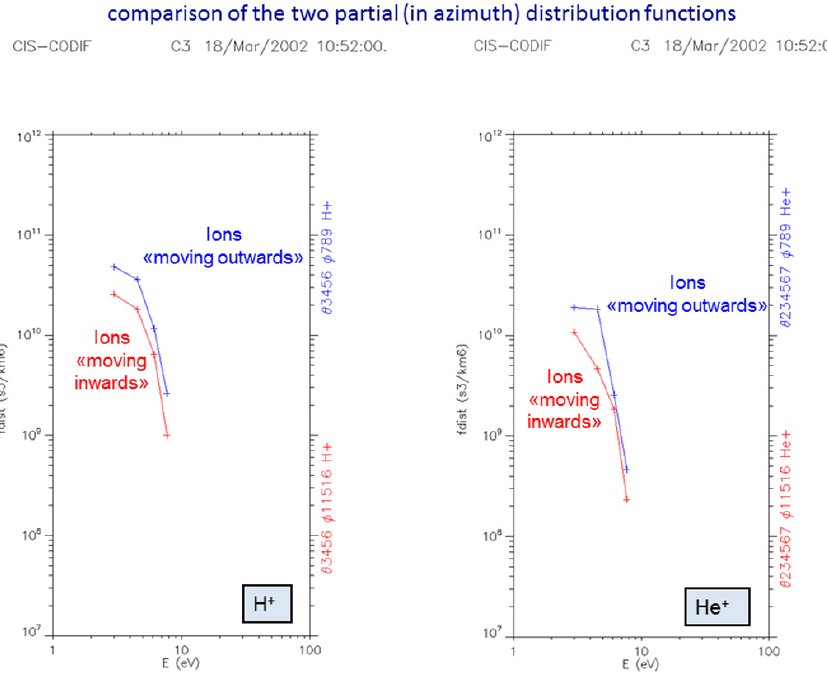
Fig. 5. Partial distribution functions in the outer plasmasphere and close to the magnetic equator, corresponding to ions flowing radially outwards (blue plots) and to ions flowing radially inwards (red plots). Left panel is for H + ions and right panel is for He + ions. Ordinate axis is in phase space density units (ionss 3 km − 6 ). The systematic imbalance between the outwards and inwards propagating ions reveals a net outward